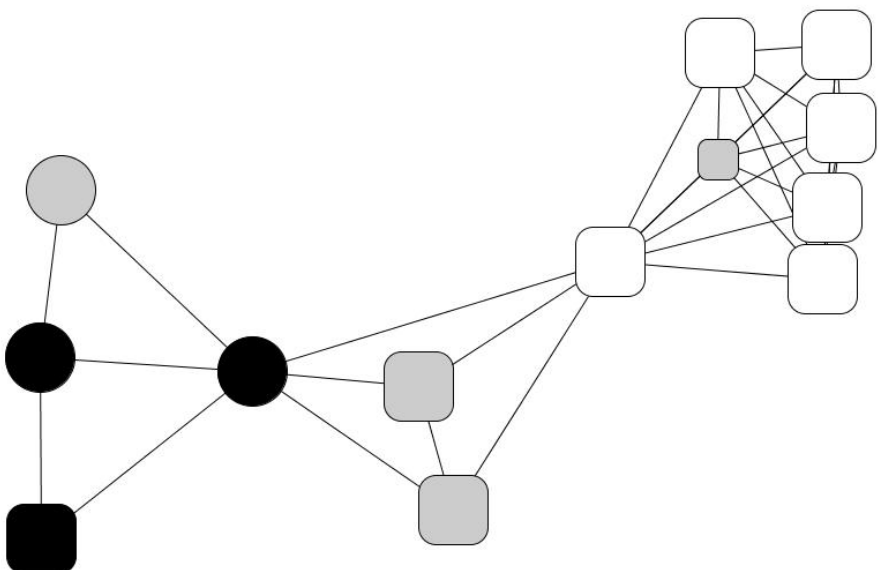
Figure 5. Andres’ personal network. Node color indicates type of relationship: family members (black), friends and acquaintances (gray), and professionals (white). Node size indicates the ego’s perception of alter’s status: big size (ego perceives that “alter has a better socioeconomic situation than me”), average size (ego perceives that “alter has a similar situation as me”) and small size (ego perceives that “alter has a worse socioeconomic situation than me”). Node shape indicates time of relationship: triangle (less than 1 year of relationship), square (between 1 and 5 years of relationship), rounded rectangle (more than 5 years) circle (lifetime).